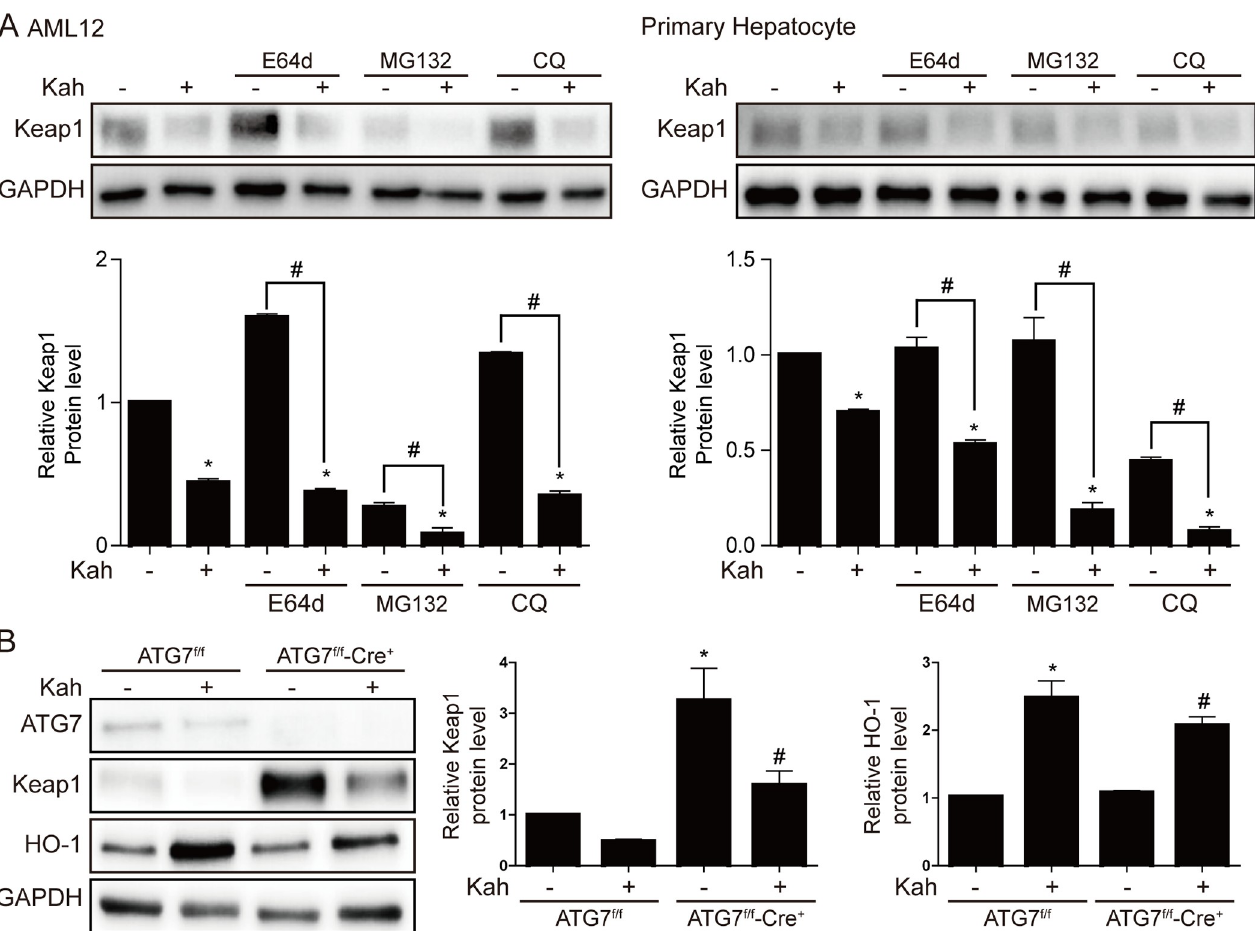
Fig 5. The effect of kahweol (Kah) on Keap1 protein degradation. ( A ) AML12 cells (left) were treated with 20 μ M kahweol and primary hepatocytes (right) were treated with 40 μ M kahweol in the absence or presence of E64d (10 μ M), MG132 (0.5 μ M), or chloroquine (CQ; 10 μ M). Data in the bar graph are means ± SEM of three independent measurements. � p < 0.05 compared with the control. # p < 0.05. ( B ) Western blot analyses of Keap1 and HO-1 protein levels, in primary hepatocytes from ATG7 f/f Alb-Cre + (autophagy-deficient) mice. Data in the bar graph are means ± SEM of three independent measurements. � p < 0.05 compared with the ATG7 f/f , # p < 0.05 compared with the ATG7 f/f -Cre +